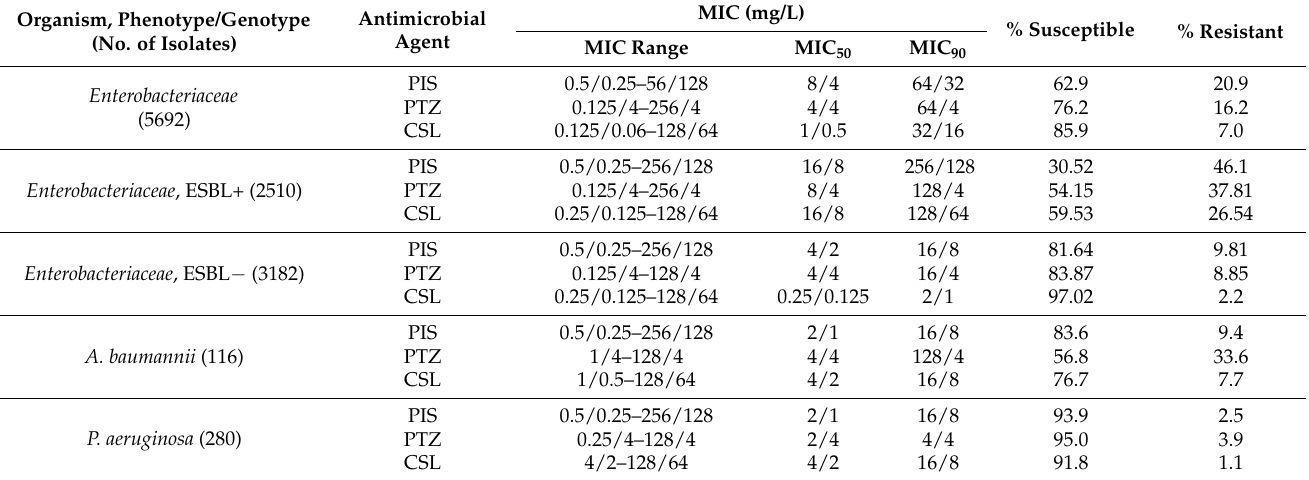
Table 1. In vitro antibacterial activity of PIS, PTZ, and CSL against Gram-negative isolates from blood